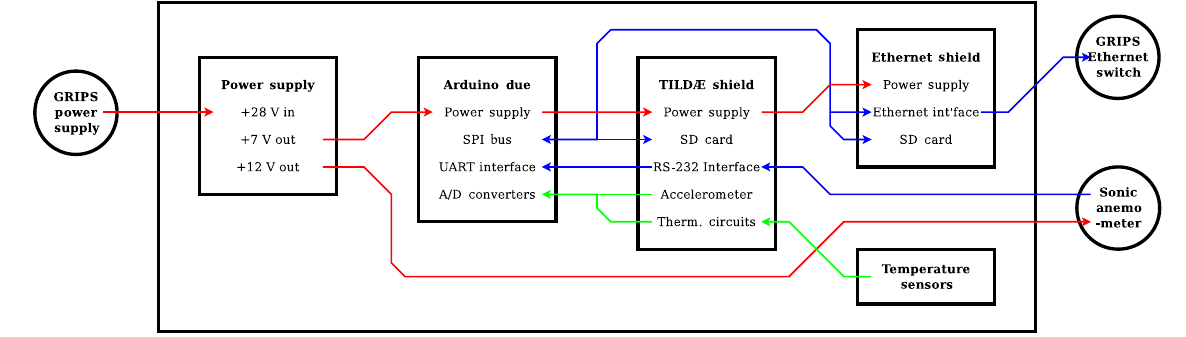
Figure 3. Simplified system diagram of TILDAE’s electronics box. The key components within the box are shown in rectangles while external components are shown in circles. Arrows indicate the connections between components and are colored based on their function: red for power, blue for digital signals, and green for analog